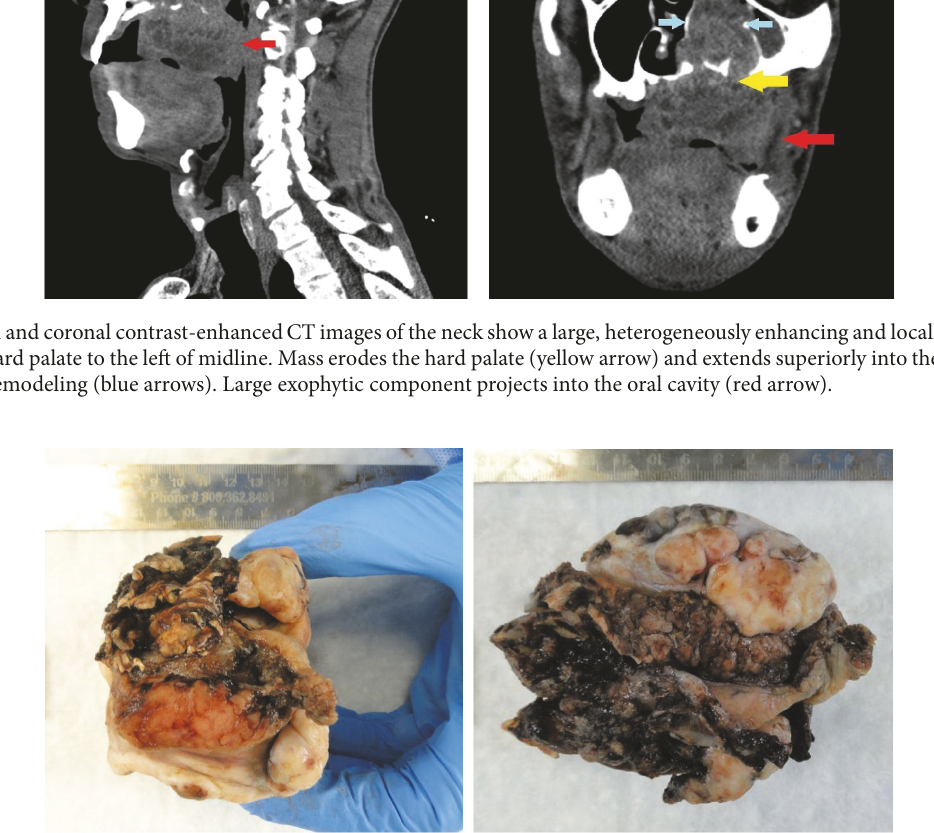
Figure 2: Representative images of near-total maxillectomy specimen measuring 9.2 × 6.5 × 6.5 cm overall. Examination revealed a 7.0 × 6.5 × 5.2 cm light tan, solid tumor replacing the majority of the hard